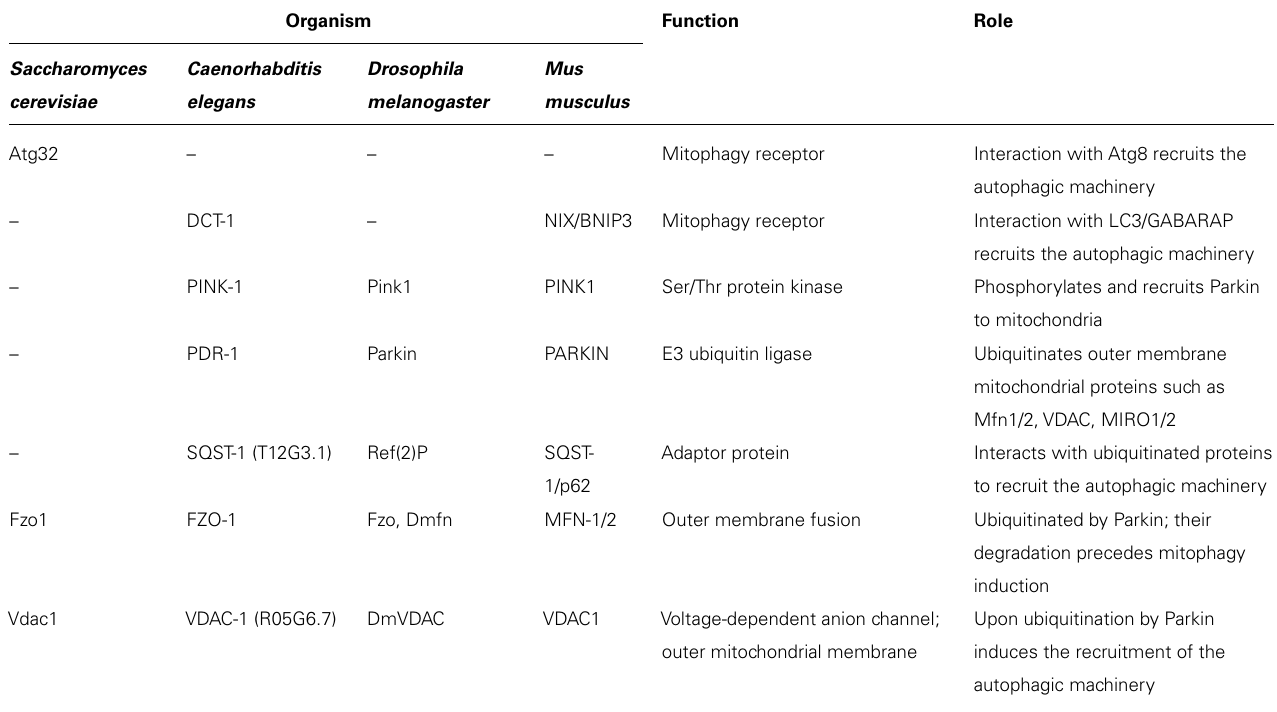
Table 1 | Mitophagy-specific factors are highly conserved form yeast to